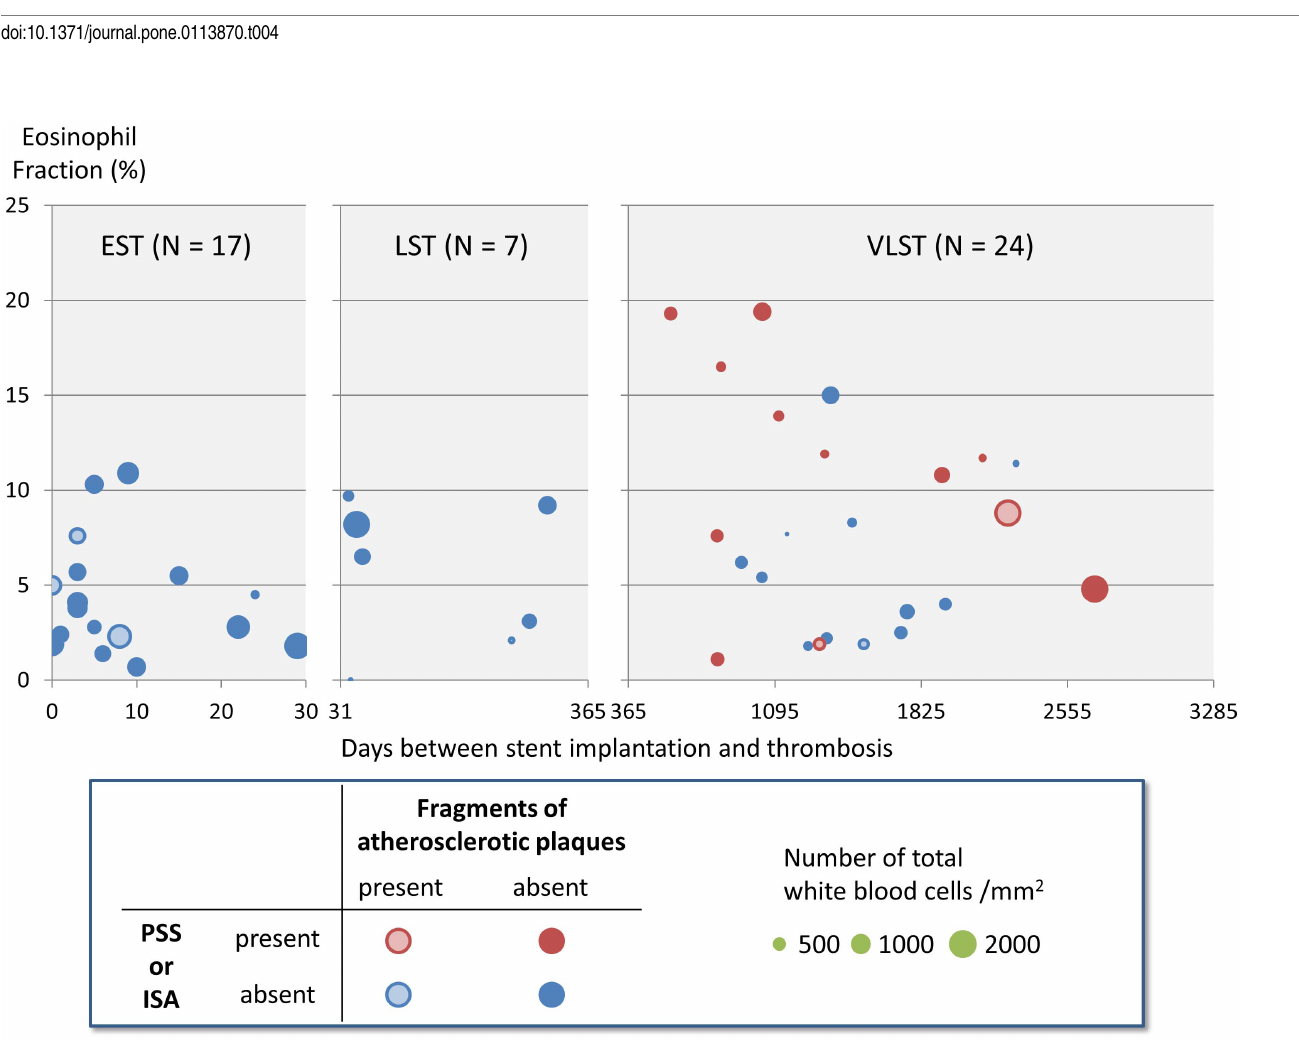
Figure 2. Bubble plots for eosinophil fraction in the aspirated thrombi and days between stent implantation and thrombosis in patients with and without PSS or ISA. Bubble size shows total white blood cell counts per mm 2 in the aspirated thrombi. EST 5 early stent thrombosis, LST 5 late stent thrombosis, VLST 5 very late stent thrombosis, PSS 5 peri-stent contrast staining, and ISA 5 incomplete stent